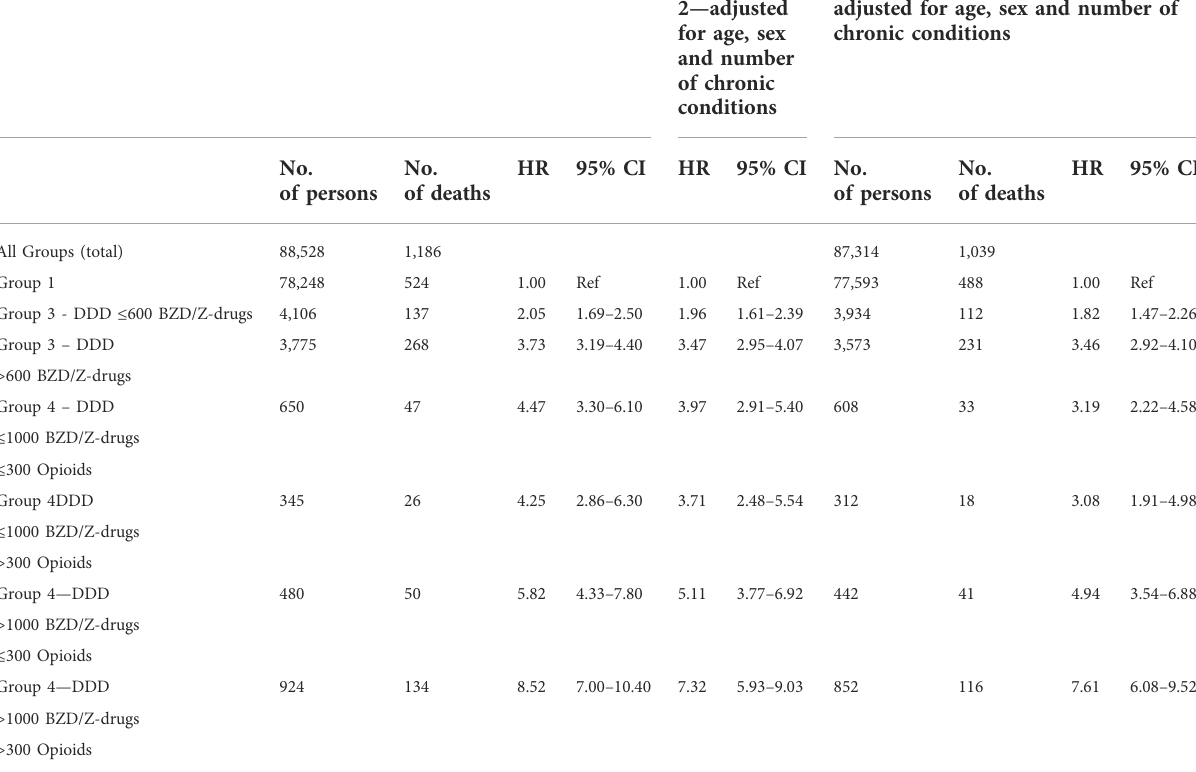
TABLE 4 Dose-dependent relationship between long-term use of benzodiazepines/Z-drugs, opioids, morbidity and mortality. Cox proportional hazards regression is used for models 1 – 3, Groups 3 and 4. Model 1 — adjusted for age and